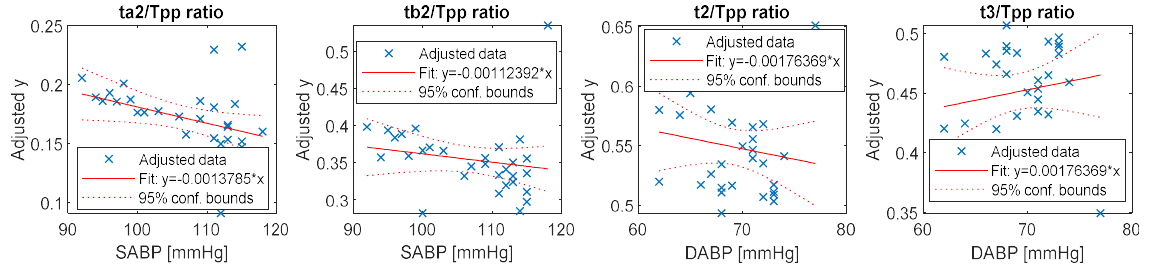
Figure 1. Example of SD-PP signal with marked positions of a 2, b 2, e 2, and f 2 points and definition of time features ta 2, tb 2, t 2, and t 3 together with partial areas PAo-a2, PAa2-b2, PAb2-e2, and PAe2-f2.